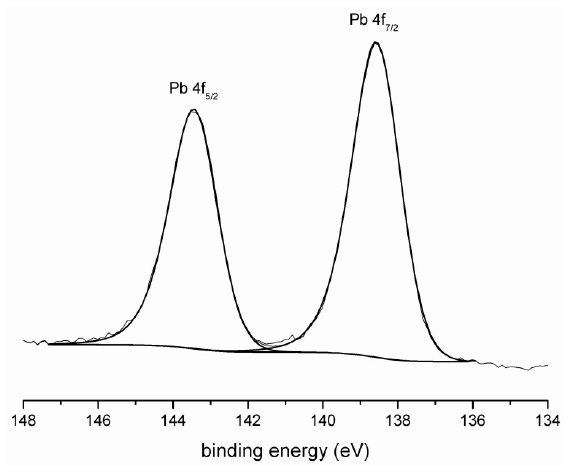
Figure 1. X-ray photoelectron spectroscopy (XPS) spectrum of Pb.